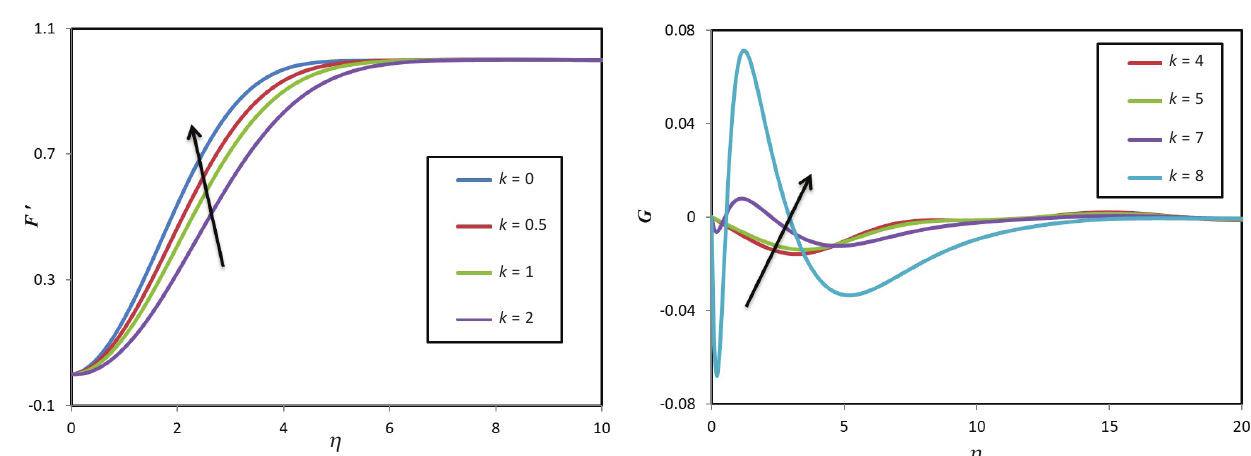
Fig. 10 – dF/d h (primary velocity) versus h for I = 0.5, F = –0.5 (heat sink), Pr = 100 (weak polymers), m = 0.3 (general wedge flow), Ec = 0.2, with K = 0 (Newtonian), 0.5, 1, 2, 5